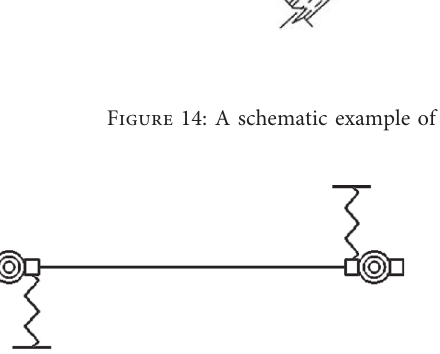
Figure 15: Schematic model of link beams in eccentric